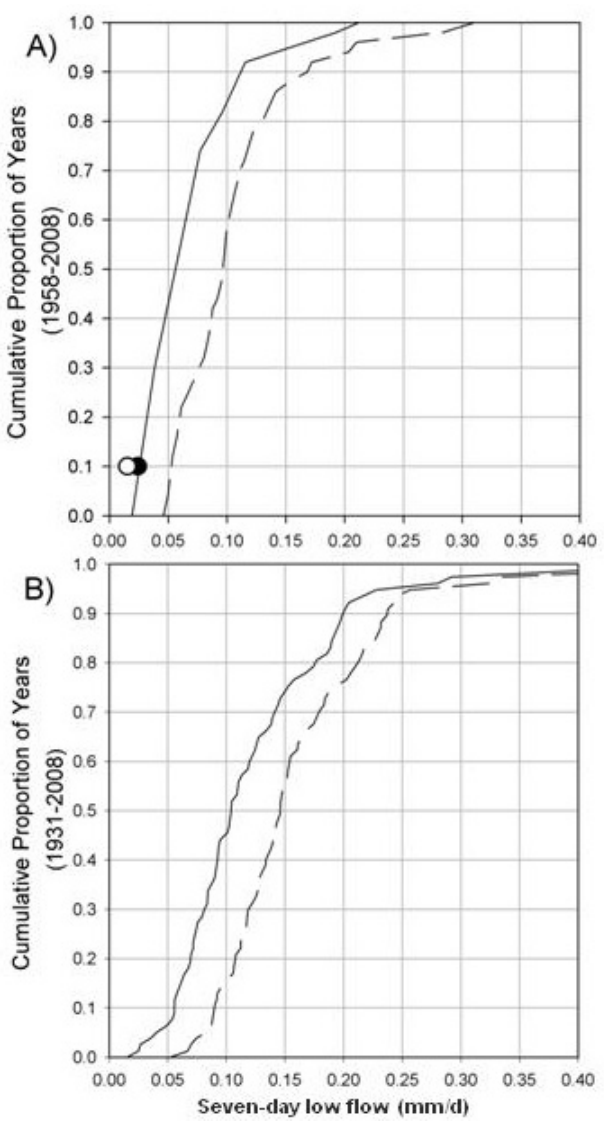
Fig. 4. Cumulative distributions of measured seven-day annual low flows for several stations in the Potomac River Basin. (A) Two headwater tributaries. Solid line: Savage River (U.S. Geological Survey station 1596500); broken line: Wills Creek (U.S. Geological Survey station 1601500). Points were estimated using the empirical model of Carpenter and Hayes (1996). Solid circle: Savage River; open circle: Wills Creek. (B) Potomac River near Washington, D.C. Solid line: unadjusted data (U.S. Geological Survey station 1646500); broken line: adjusted data (U.S. Geological Survey station